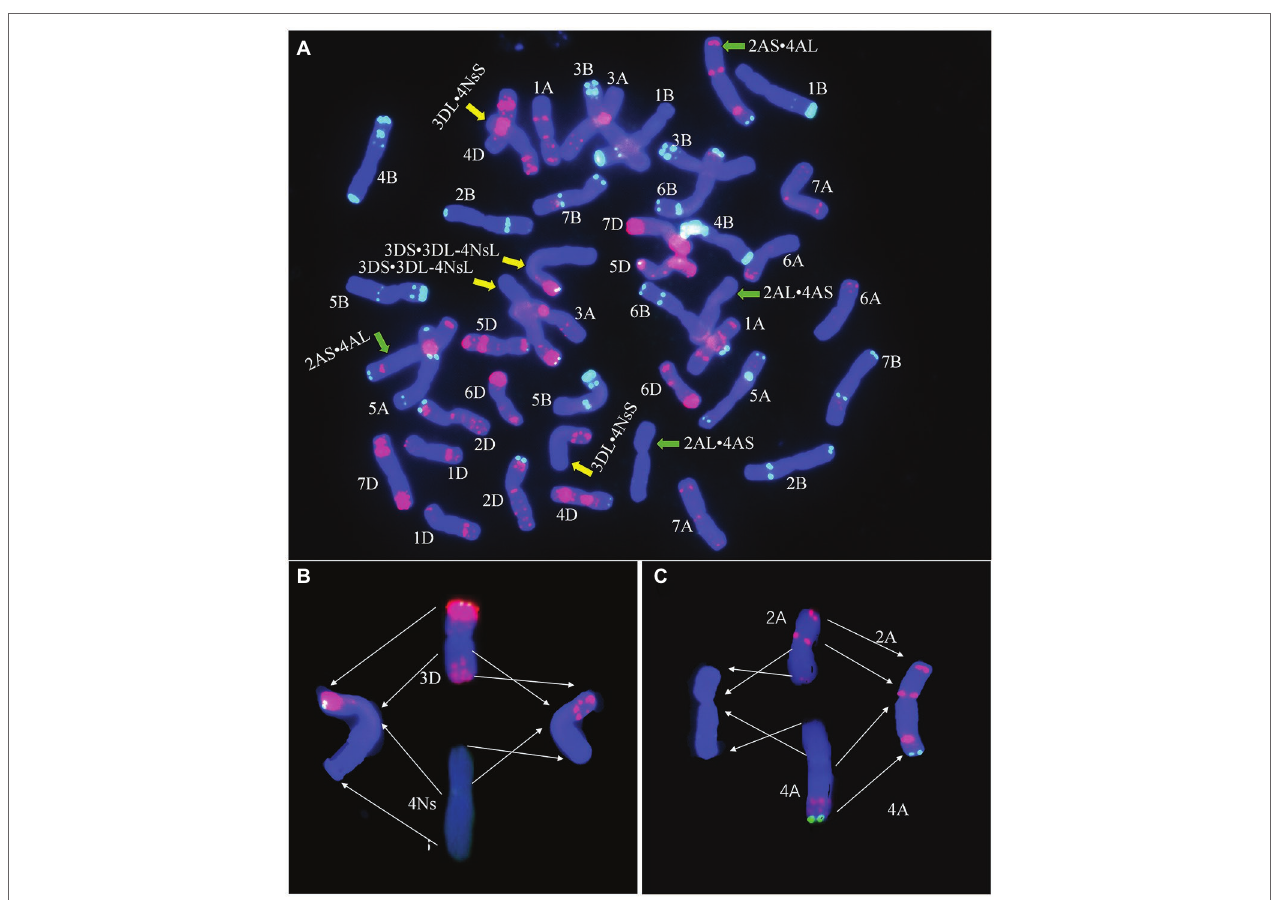
FIGURE 4 | Fluorescence in situ hybridization (FISH) analysis of E24-3-1-6-2-1 (A) . Oligo-primers pSc119.2 (green) and pTa535-1 (red) were used as probes for wheat chromosomes. The wheat 3D chromosome and P. huashanica 4Ns chromosome, as well as the wheat 2A and 4A chromosomes underwent translocations to form 3DS·3DL-4NsL, 3DL·4NsS, 2AL·4AS, and 2AS·4AL chromosomes, as indicated by the arrows. Diagrams of translocations [3DS·3DL-4NsL and 3DL·4NsS (B) , and 2AL·4AS and 2AS·4AL (C) ] in E24-3-1-6-2-1 showing breakage sites in each chromosome, as indicated by the arrows, and chromosome rearrangements. The chromosomes were stained with 4 ' ,6-diamidino-2-phenylindole (DAPI;